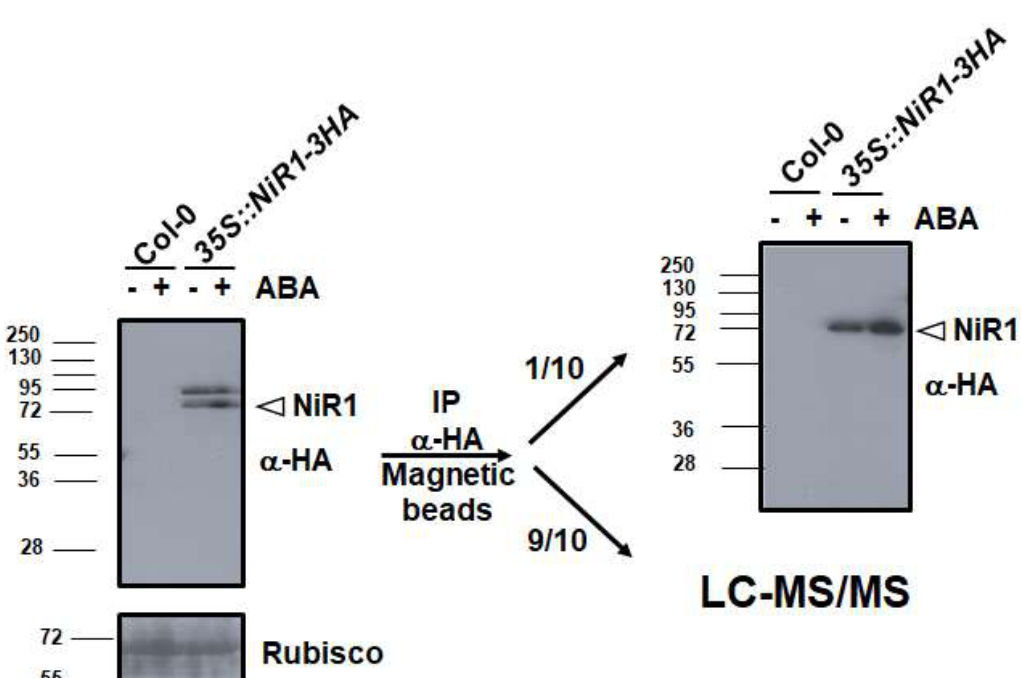
Figure 2. 35S::NiR1-3HA plants as a tool for NiR1 immunopurification and subsequent proteomic analyses. Extracts from wild-type Col-0 and transgenic plants either untreated (−) or treated with 50 μM ABA for three hours (+) were analyzed by Western blot with anti-HA antibody (left panel). Ponceau S staining of the Rubisco protein is included below as loading control. Protein extracts were further immunopurified with anti-HA-coated magnetic beads. A fraction of the immunopurified NiR1 was checked by Western blot with anti-HA antibody (right panel) and the rest of the protein samples (untreated and ABA-treated) were further analyzed by LC-MS/MS.